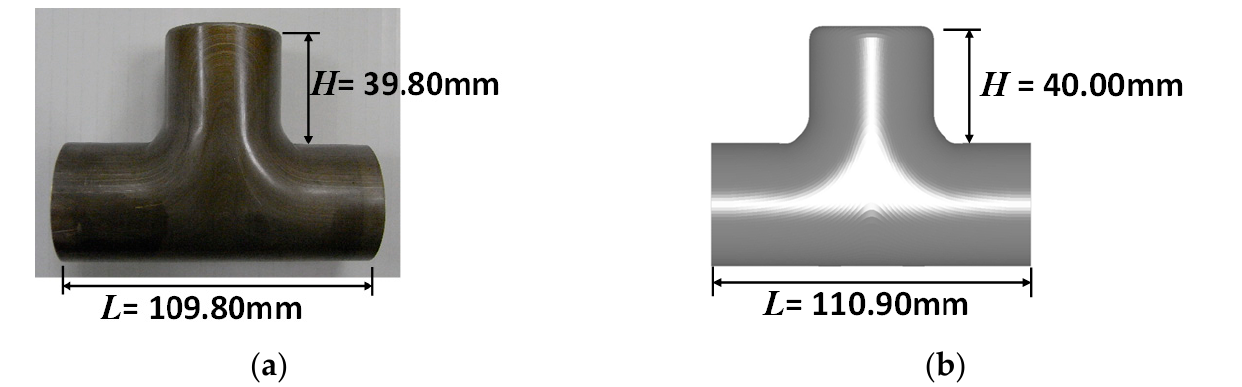
Figure 14. Comparison between the final shape and dimensions of T-shape formed products. ( a ) Experiment; ( b ) FE analysis.